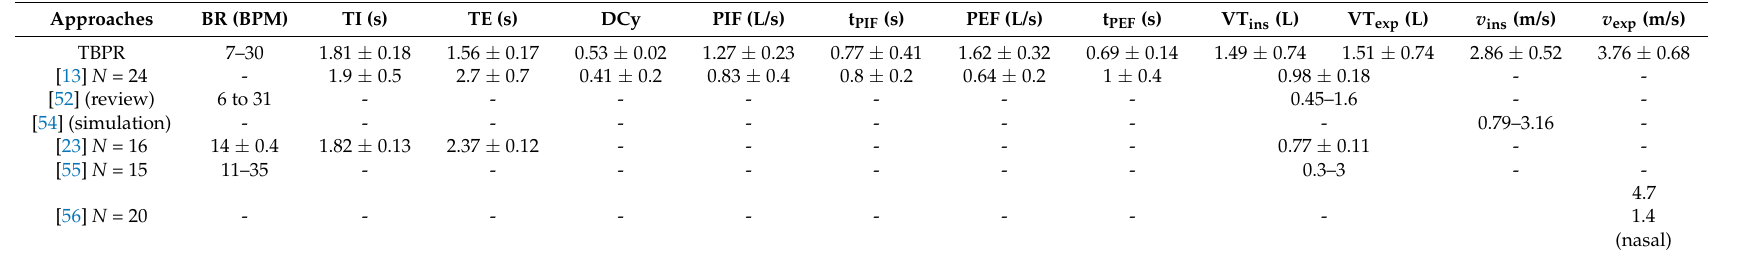
Table 5. Comparison with relevant